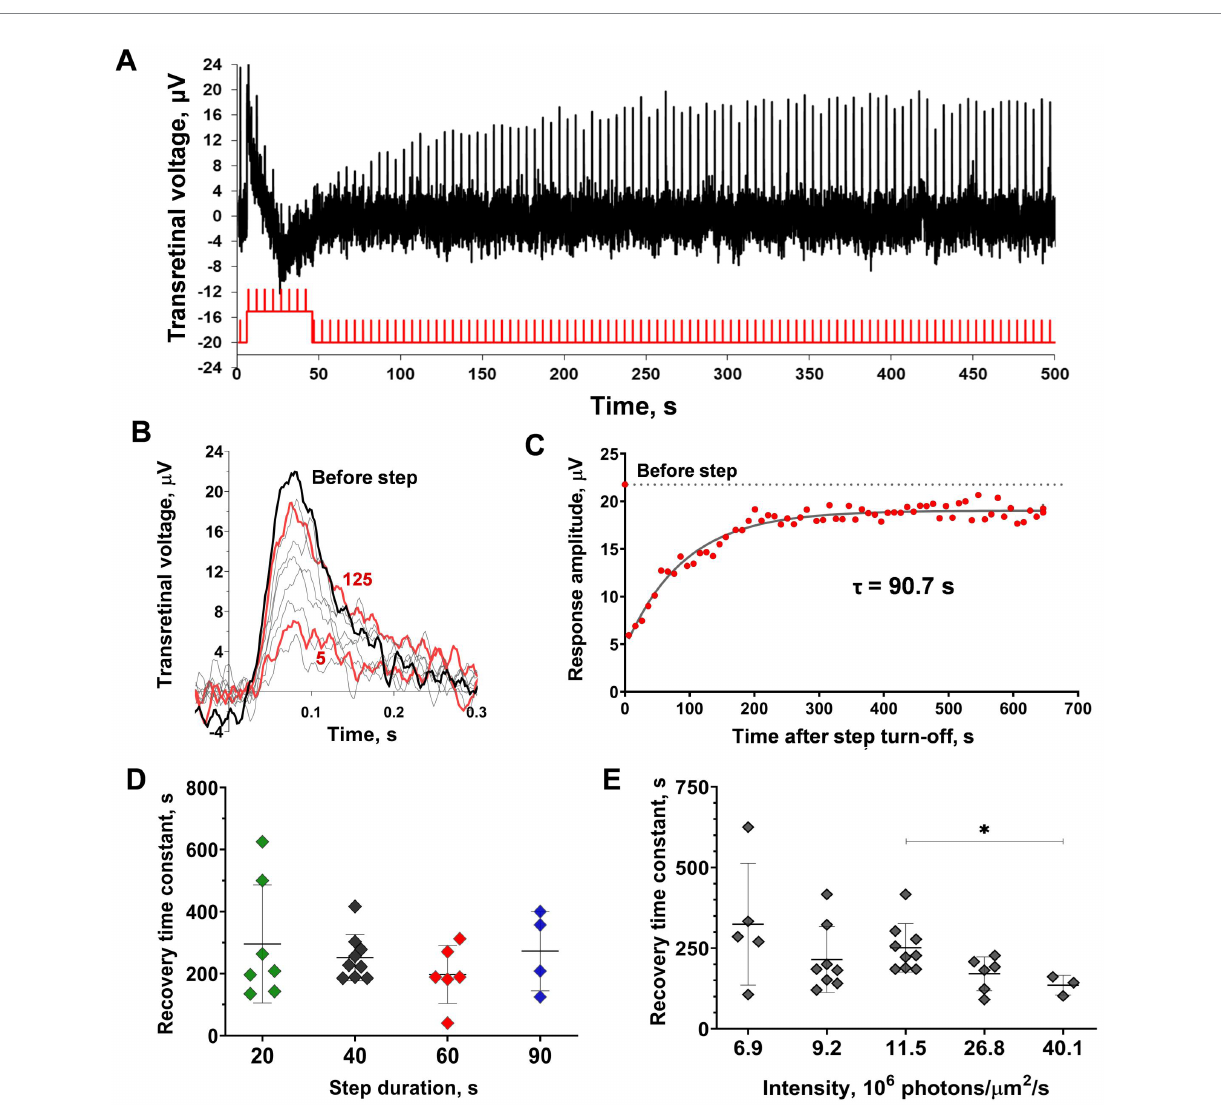
FIGURE 7 Analysis of sensitivity recovery after the light step in marsh frog red-sensitive cones based on ex vivo ERG. (A) The representative ERG-recording from the isolated frog retina after application of 10 mM sodium aspartate and the continuous green light (43,400 photons· μ m − 2 ·s − 1 ). Testing step and brief flashes were performed with red light (see Material and Methods) with intensities of 8×10 5 photons· μ m − 2 for flashes and 26.8×10 7 photons· μ m − 2 ·s − 1 for step). (B) Single responses cut from recordings (A) and superimposed for shape comparison: black bold line indicates the pre-step response, red bold lines indicate the 5th and 125th responses after the initial step during the observation period (626 s after the step turn-off), thin gray lines indicate several intermediate responses. (C) Evaluation of the rate of response amplitude recovery with an exponential function. For reference, the point plotted at time zero and the dashed line illustrates the pre-step value. (D,E) Comparison of the sensitivity recovery rate after light exposure steps of different duration (D; 20, 40, 60, and 90 s) and intensities (E) . Asterisk * indicates statistically significant differences between groups (Dunnett’s multiple comparisons test; p < 0.05). Sample sizes n =